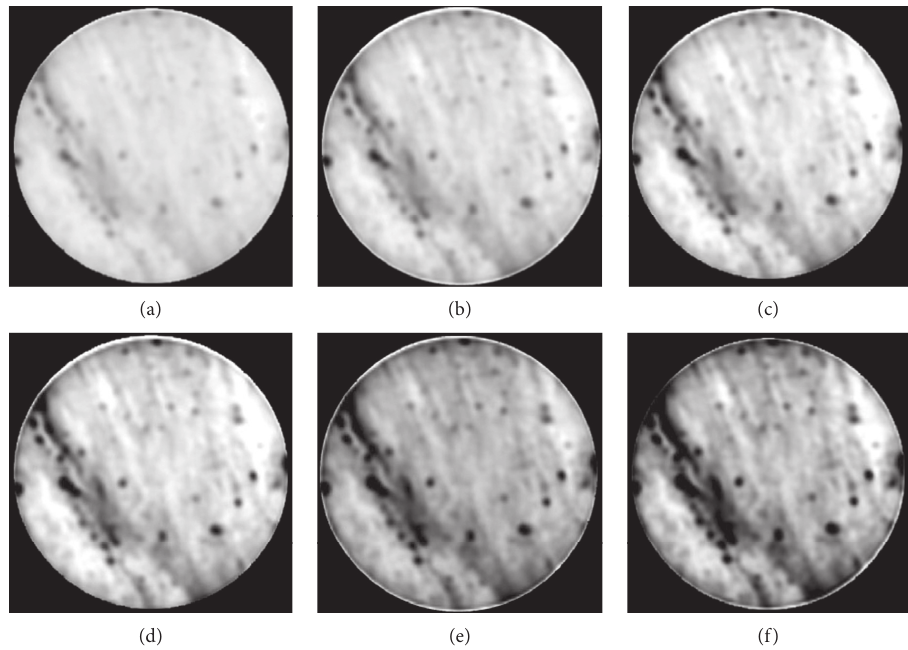
Figure 5: CTimages of the 10 th slice of fine red sandstone M1 after freeze-thaw cycles. (a) 0 cycles. (b) 20 cycles. (c) 40 cycles. (d) 60 cycles. (e) 80 cycles. (f) 100